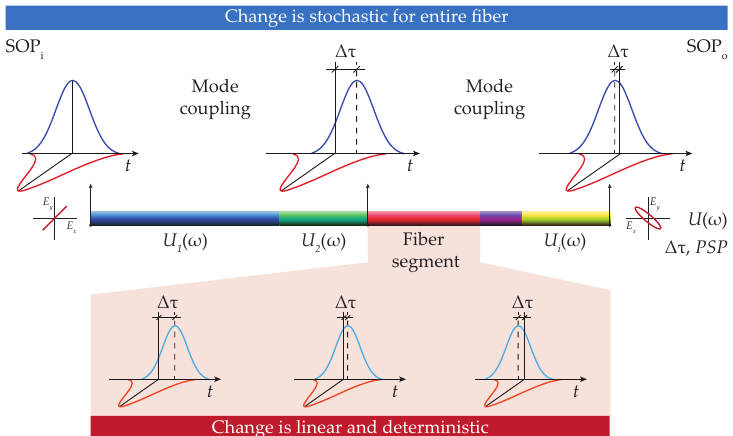
Figure 2. Schematicofthein-housenumericalmodeltostudypolarizationmodedispersion(PMD)-impaired optical pulse propagation in the optical fiber. The light polarization state at the fiber output is completely described by the input state of polarization and propagation of optical pulse through the optical fiber with a randomly varied parameters. Here, each fiber segment (different colored sections along the light propagation direction) is represented with different light polarization properties, i.e., by random birefringence. SOP i denotes the initial state of light polarization, SOP o is the state of light polarization at the fiber output, U i ( ω ) is the individual Jones matrix, PSP is the principal state of polarization, and ∆ τ is the differential group delay (DGD). The later parameters used in the in-house model are fully retrieved from the experimental